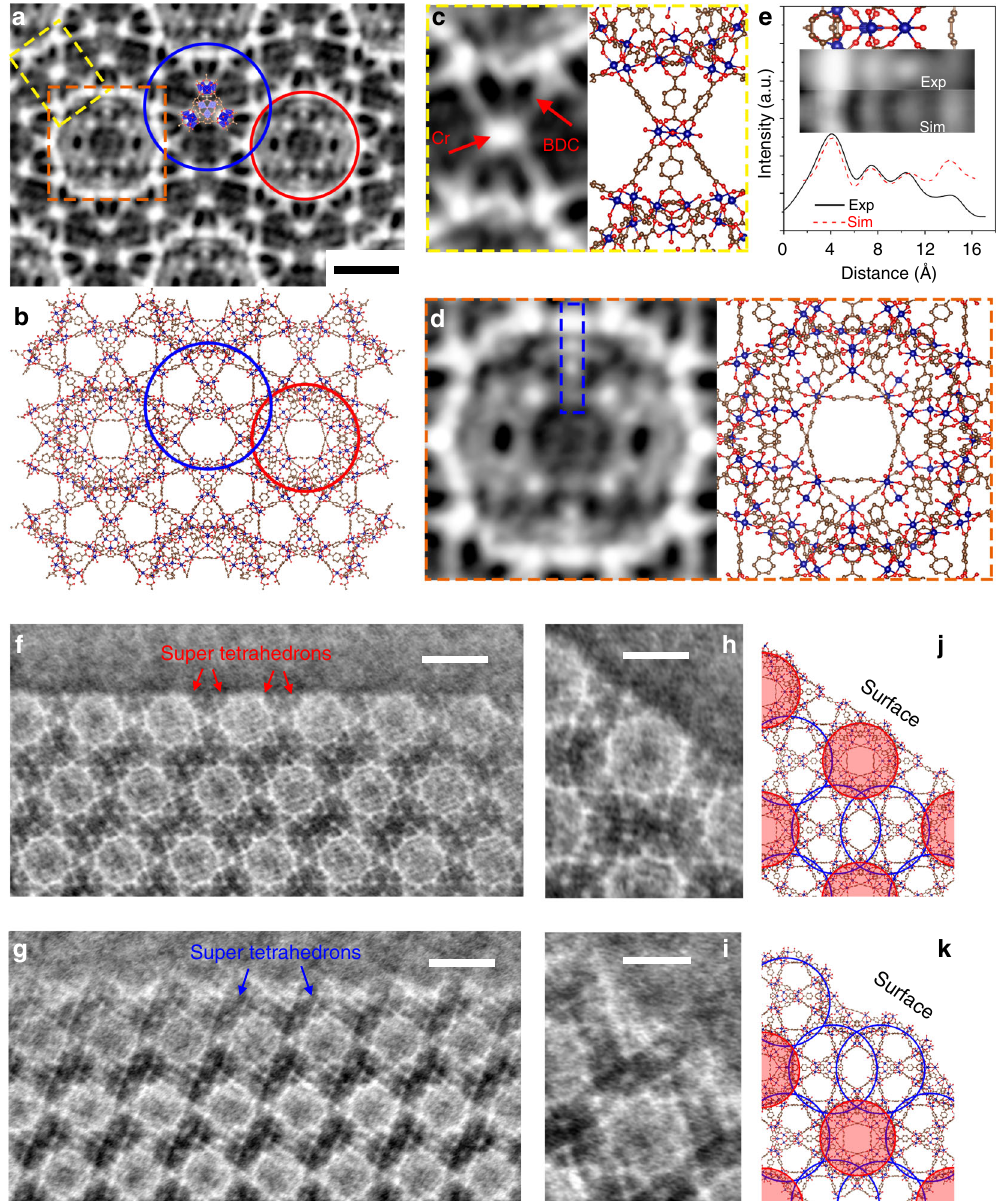
Fig. 3 Imaging the atomic lattices and surface structures in the MIL-101 crystals. a , b Imaging the atomic MIL-101 lattice in the averaged iDPC-STEM image. The red and blue circles indicate two types of cages with 29 and 34 Å sizes, respectively. Scale bar, 1 nm. c Imaging the super tetrahedrons formed by Cr nodes and BDC linkers (marked as the yellow frame in a ). d Imaging the structure in 29 Å cage in the MIL-101 (marked as the orange frame in a ). e The pro fi le analysis of image (exp) and simulation (sim) of the detailed structures in the blue frame in d , which helps to resolve the Cr columns in the frameworks. f , g Two types of surface terminations with two types of cages exposed on the {111} surfaces. Scale bars, 5 nm. h , i The structures of single- unit cells at two types of surface terminations, respectively. Scale bars, 3 nm. j , k The structural models of h and i showing the {111} surfaces terminated by different